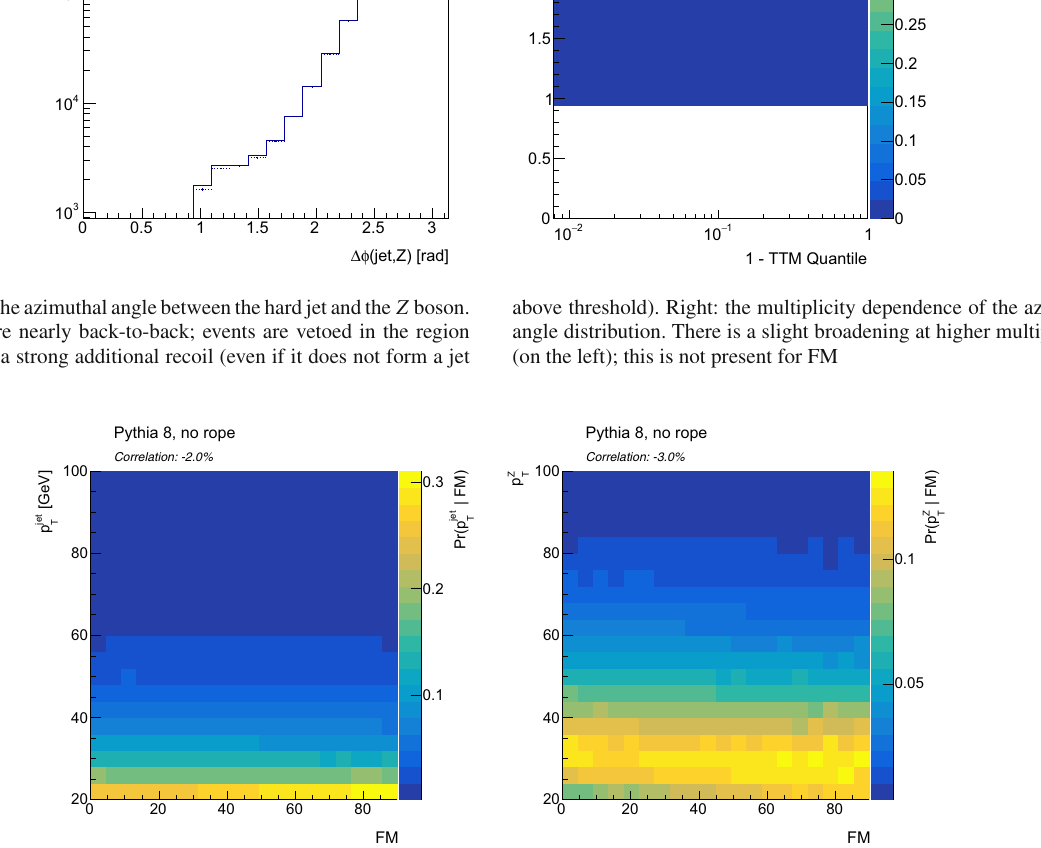
tum fraction carried by identified hadrons is given